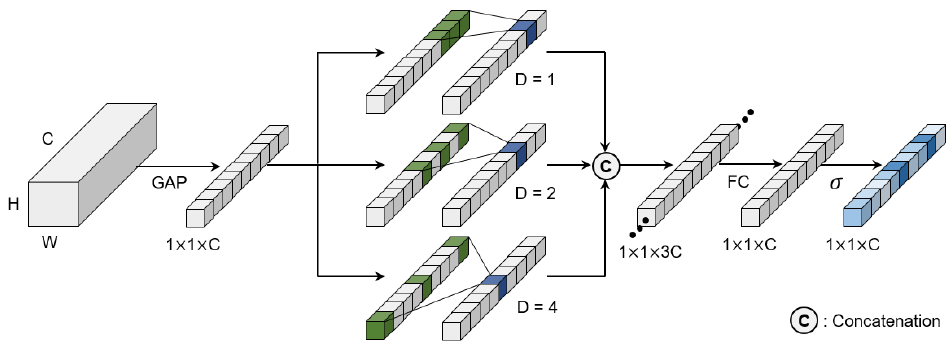
Figure 2. Structure of PDA module.